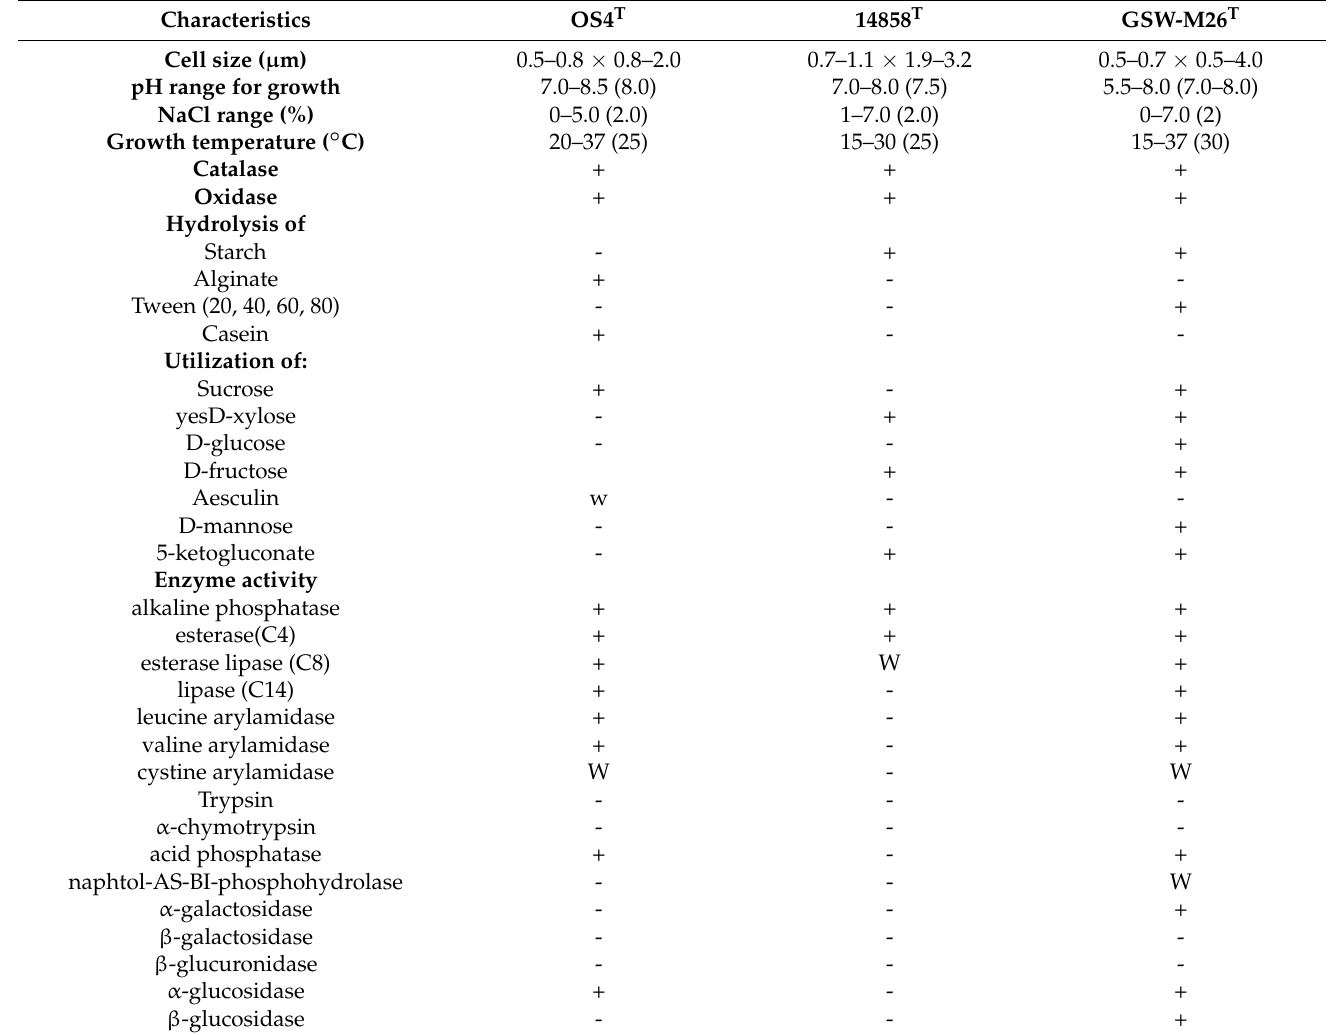
Table 1. Differential phenotypic characteristics of strain OS4 T and its related species.